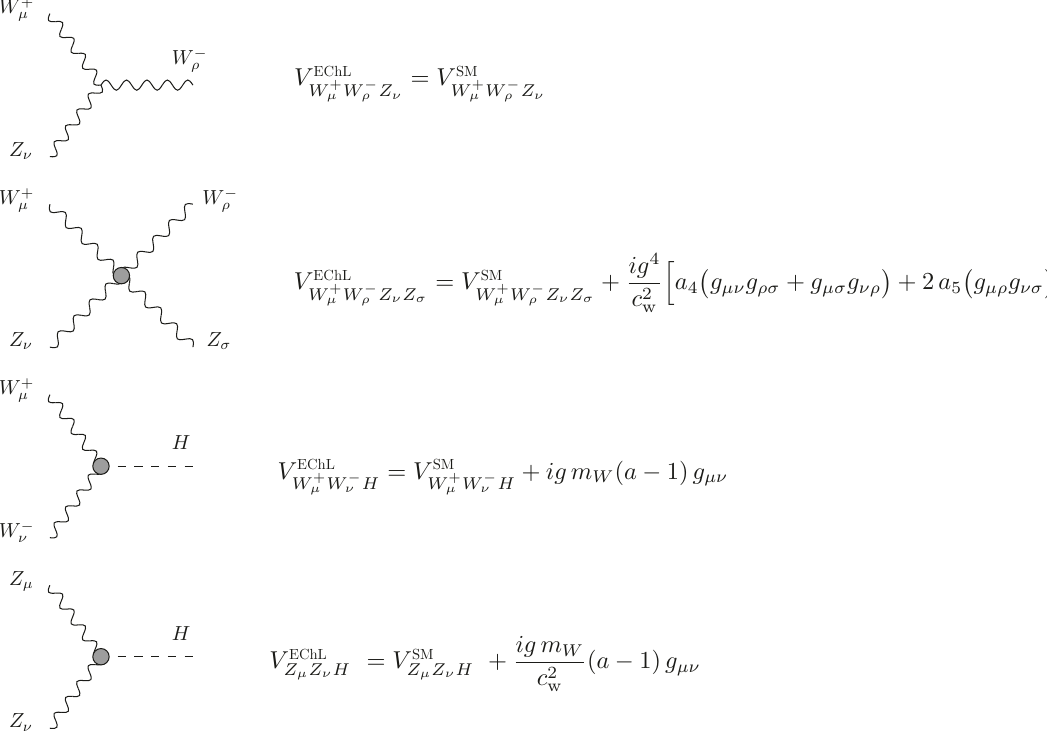
WZ process in the EChL. Gray circles represent !